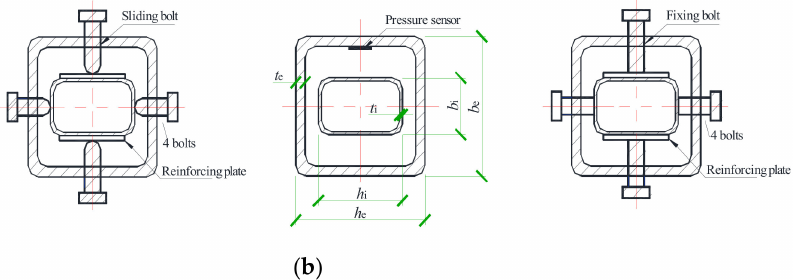
Figure 4. Specimen of buckling monitoring member: ( a ) Parameters of specimen; ( b ) cross -section of the core tube and restraining tube.